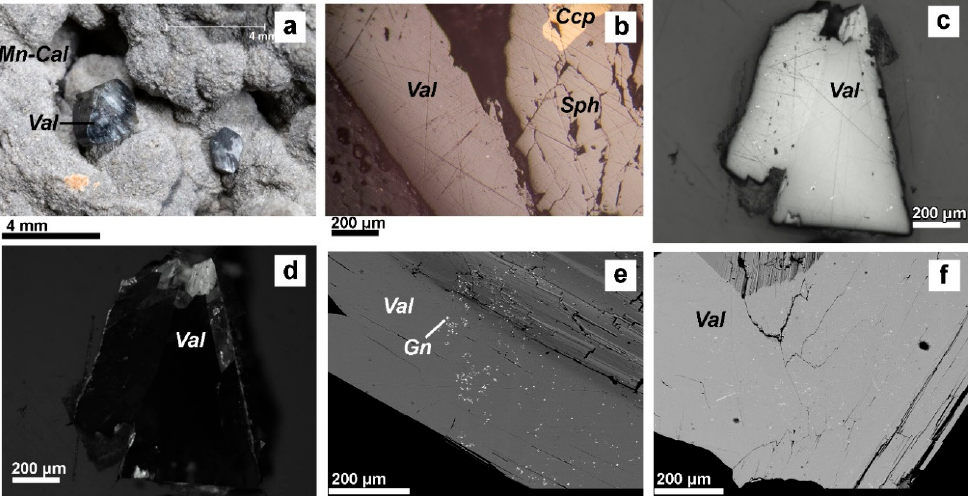
Figure 3. Macroscopic, reflected light, and backscattered (BSE) images: ( a ) macroscopic images of valentinite, ( b – d ) reflected light parallel and crossed polarizers; ( e,f ) BSE images. Val—valentinite; Sph—sphalerite; Ccp—chalcopyrite; Mn-Cal—manganese-bearing calcite.